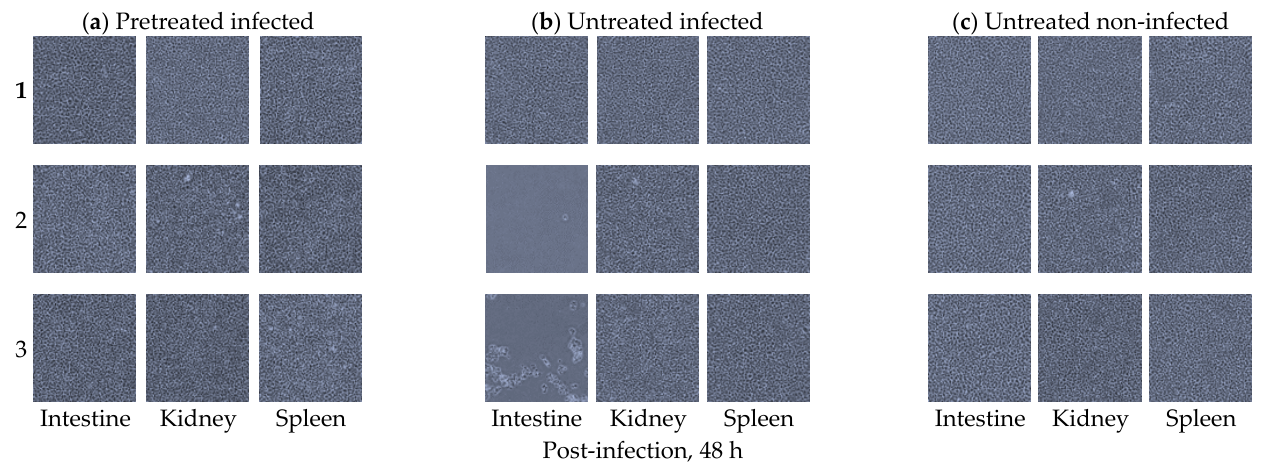
Figure 3. EPC cells inoculated with intestine, kidney, or spleen tissue homogenates from olive flounder ( Paralichthys olivaceus ). ( a ) Replicates of intestine, kidney, and spleen tissue homogenates cultured in EPC cells. Homogenates are from the orally B. subtilis -pretreated olive flounder at a concentration of 10 6 CFU/mL examined 48 h after the VHSV infection. Note the absence of cytopathic effects (CPE) in all the tissues examined. ( b ) Replicates of intestine, kidney, and spleen tissue homogenates cultured in EPC cells. Homogenates are from B. subtilis -untreated olive flounder examined 48 h after the VHSV infection. Note the presence of CPE in two samples of the intestines and absence of CPE in the spleen and kidney replicates. ( c ) Replicates of intestine, kidney, and spleen homogenate tissues cultured in EPC cells from B. subtilis -untreated olive flounder that were not infected by VHSV examined after 48 h. Note the absence of CPE in all the tissues examined. All images were visualized by phase-contrast microscopy at 100× magnification.